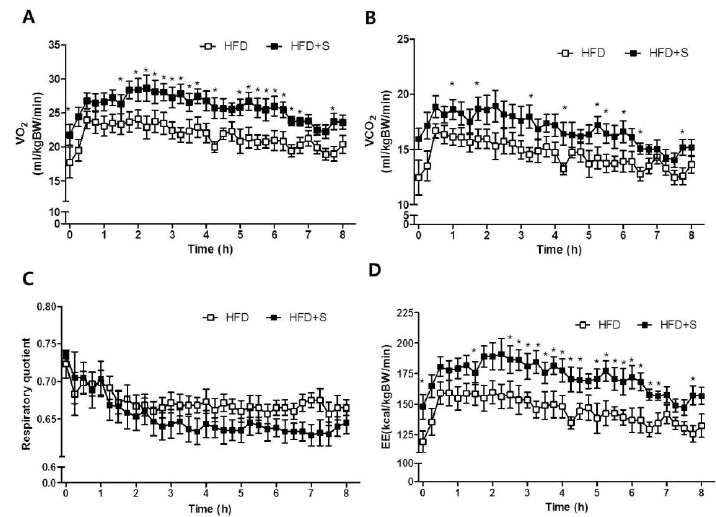
Figure 6. Shikonin stimulates fatty acid oxidation and promotes energy expenditure in HFD-induced obese mice. HFD-induced obese mice were orally administrated vehicle or shikonin for 4 weeks. After administration, mice were transferred to a chamber and ( A ) VO 2 , ( B ) VCO 2 , ( C ) respiratory quotient, and ( D ) energy expenditure were measured using indirect calorimetry for 8 h during dark cycles. Values represent the mean ± SEM of eight mice.